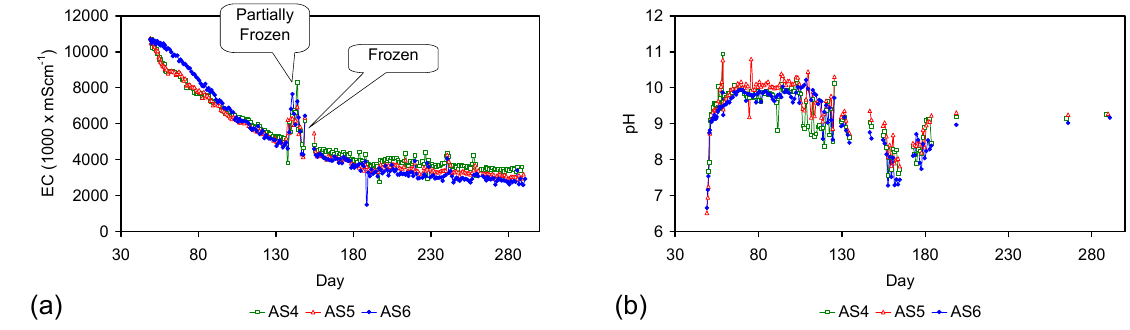
Figure C3. ( a ) EC vs. day; ( b ) Eh vs. day; ( c ) pH vs. day; ( d ) pH vs. Eh. ZVM TP = particulate material placed in water at a concentration of PS11 = 26.5 g·L − 1 ; PS12 = 14.3 g·L − 1 ; PS13 = 5.65 g·L − 1 ; PS14 = 10.2 g·L − 1 . Reactor Size: 2.3 L; Feed Water volume: 2.3